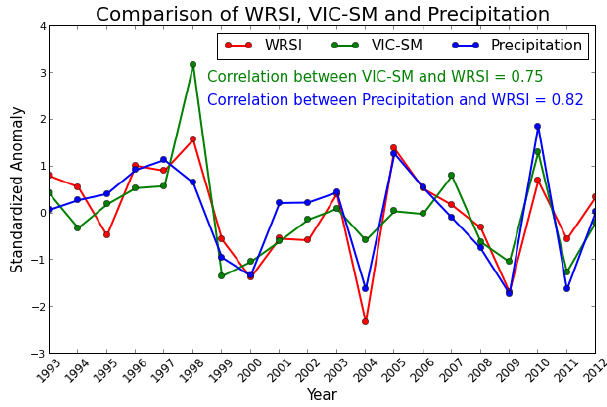
Figure 5. Comparison of MAM precipitation, SM a posteriori esti- mates (VIC-SM) and end-of-season (EOS) WRSI for crop zones in the focus domain for each year between 1993 and 2012.